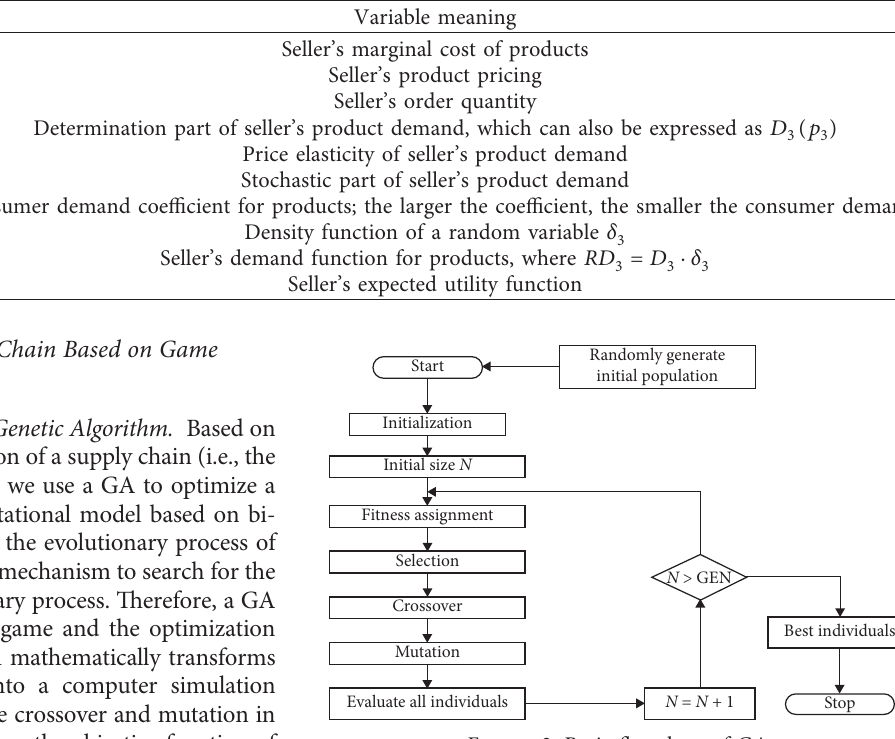
Table 1: Notation and definitions for the newsboy model.